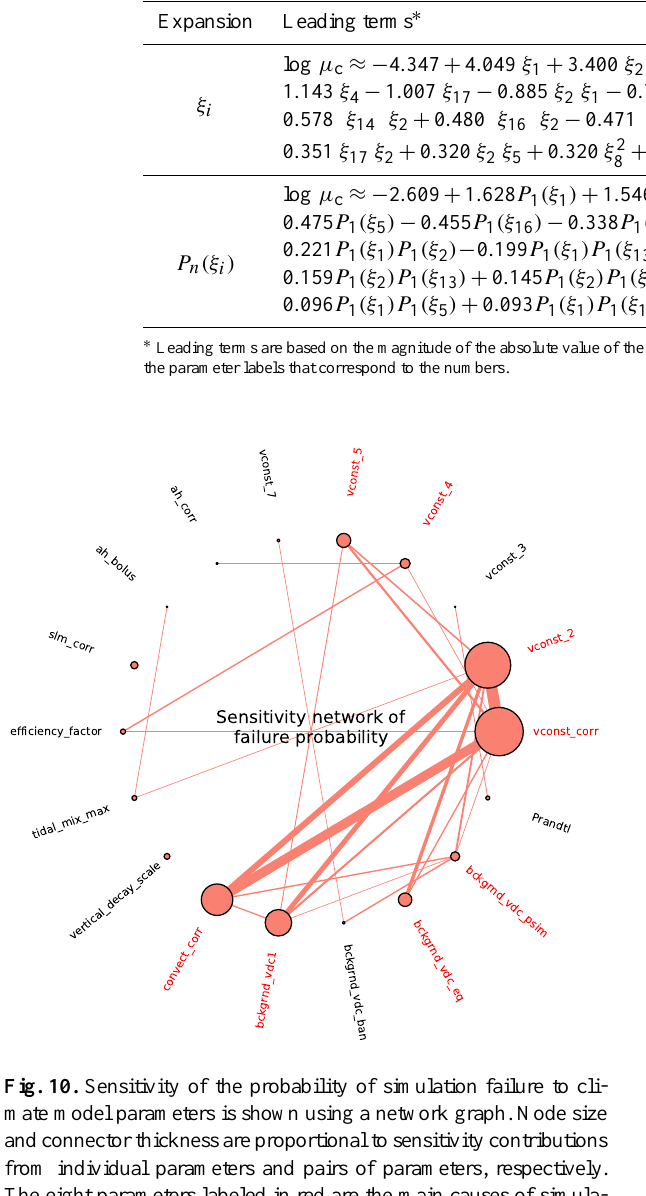
Table 4. Polynomial chaos expansion of failure probability.